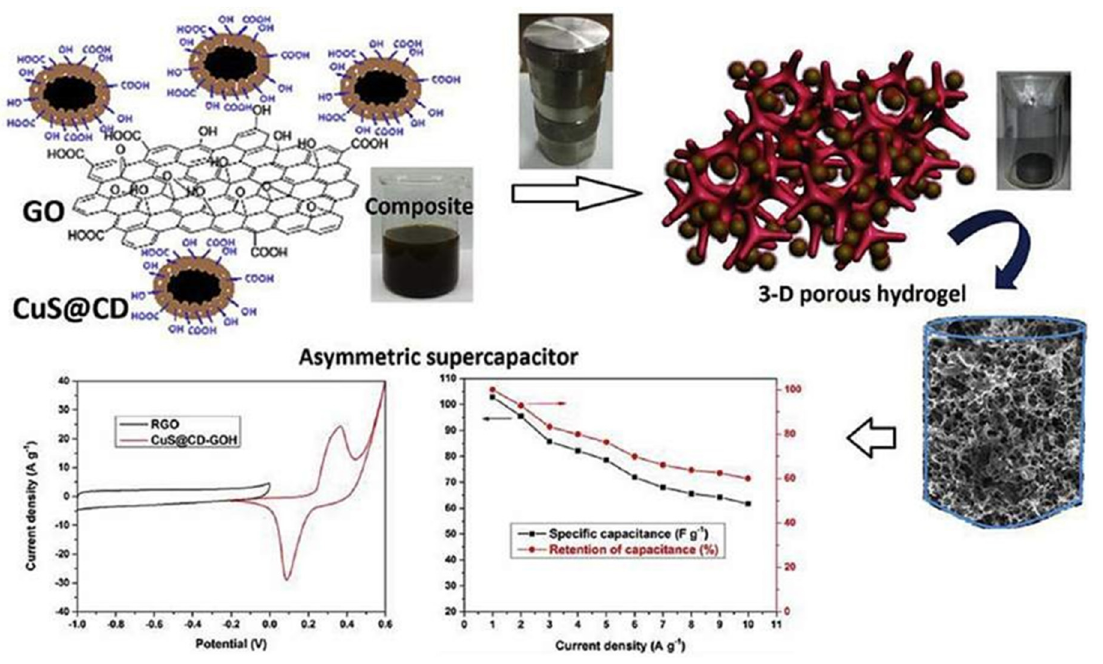
Figure 18. Carbon dot/copper sulfide nanoparticles-adorned GO hydrogel for storage applications. Reproduced with permission from [97].